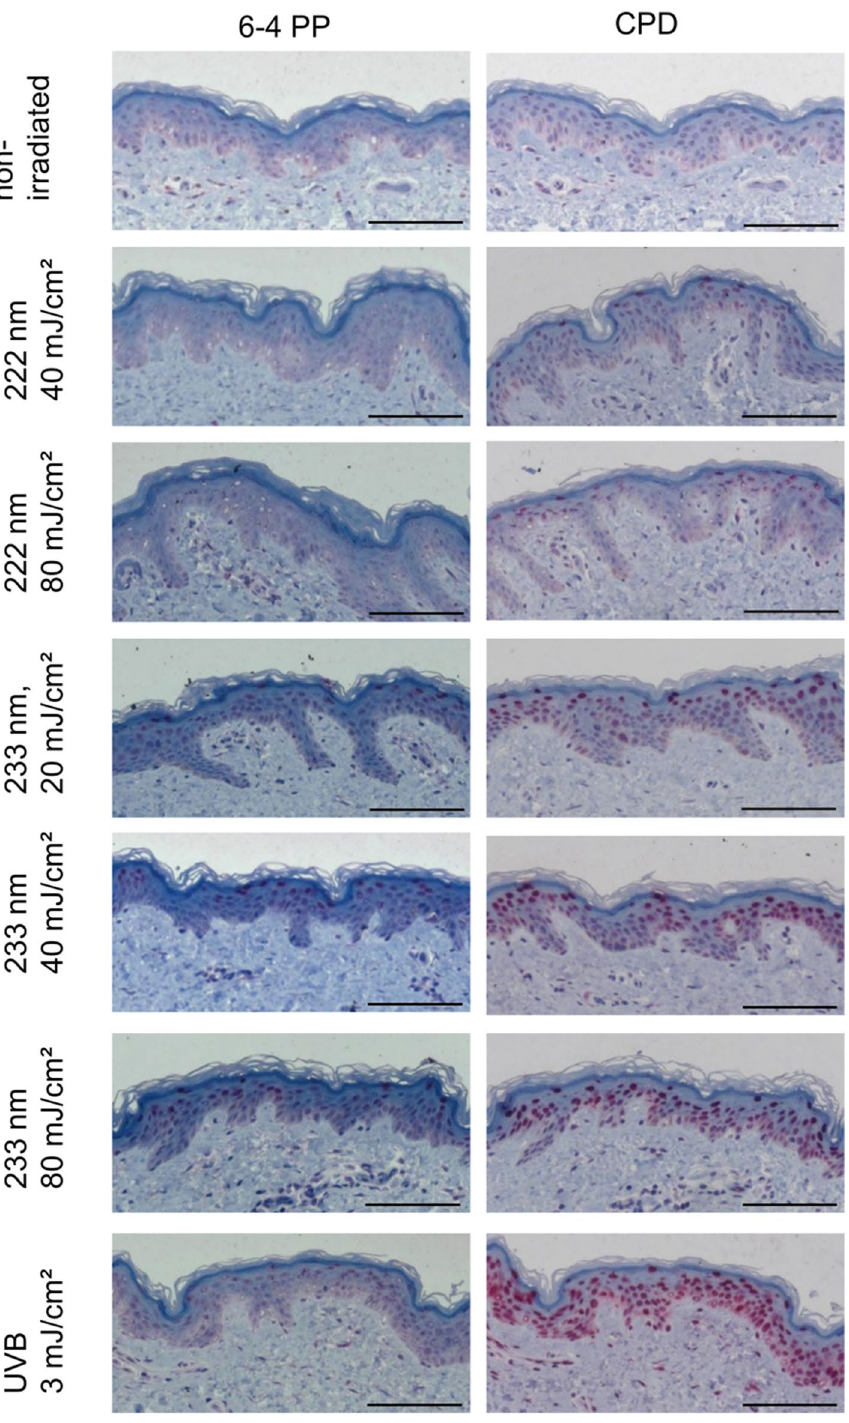
Figure 5. Representative images of histological analysis of DNA damage in excised human skin. Paraffin sections are stained for 6-4PP (left column) and CPD damage (right column). Positive cells are stained in dark red. Non-irradiated human skin (negative control) shows no positive cells. Human skin irradiated with 3 mJ/ cm 2 UVB (0.1 MED) showed > 80% CPD damage throughout the whole epidermis. The CPD damage after 40 mJ/cm 2 irradiation at 222 nm and 233 nm only occurred on the uppermost layer of the epidermis. Scale bar: 100